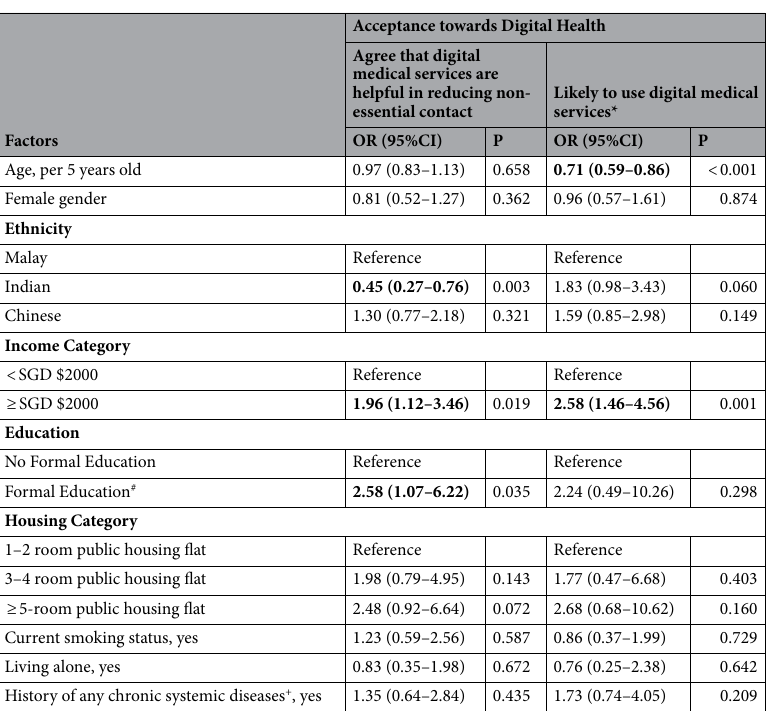
Table 5. Association between demographic, socio-economic factors and medical history with Digital Health Acceptance. SGD = Singapore Dollar. *Answered either ‘Somewhat likely’ or ‘Very likely’ for the question on likelihood of using digital medical services. # Defined as having primary or higher education. + Defined as having diabetes, hypertension, chronic kidney disease, cardiovascular disease or